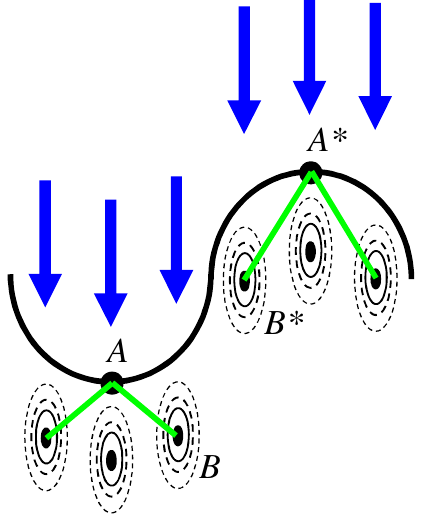
Figure 2. Schematic drawing of the energy deposition in rough surfaces, see